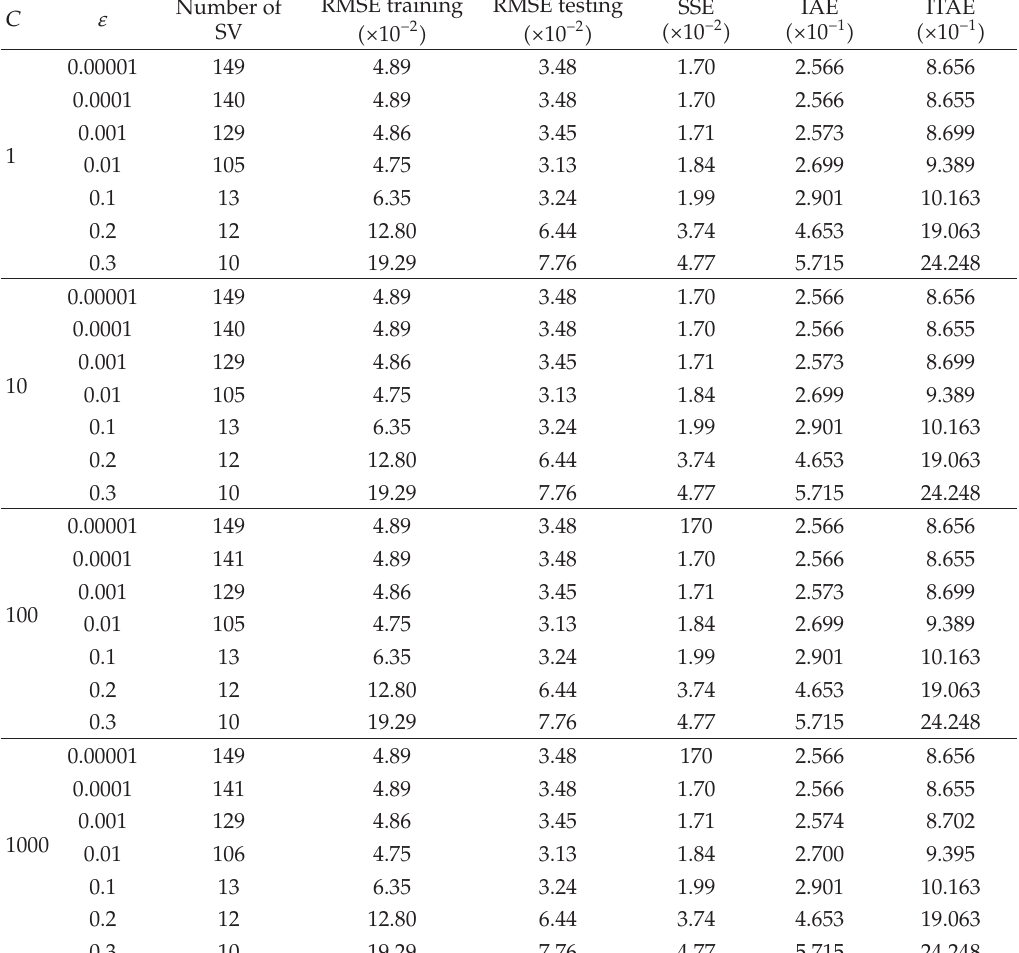
Table 1: Learning results of an SVM regression with di ff erent values of C and ε